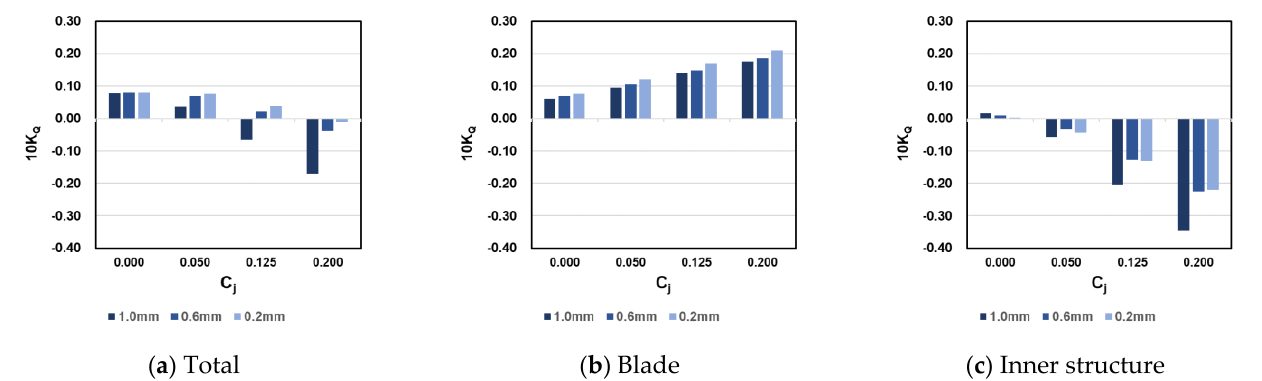
Figure 17. 10K Q according to C j for each part of the propeller with each slit height ( J A = 0.4). In Figure 18, the torque PUA distribution by jet injection becomes almost the same as the thrust distribution. Similar to the thrust, behind the slit, a large torque increase is shown when jet injection guides the downwash, and the mass flow is concentrated. The jet injected from the slit generates thrust from the surface of the blade while guiding the downwash by the Coanda effect, and at the same time, higher wall shear stress is generated by the jet, so the distribution of thrust and torque is similar. However, in the case of wall shear stress, the flow near the wall is dominated by the influence of velocity particular. Therefore, as C j increased at all slit heights, so did the wall shear stress. Therefore, unlike Figure 14b, it can be confirmed in Figure 17b that the lower the slit height, the more the torque on the blade tended to increase.